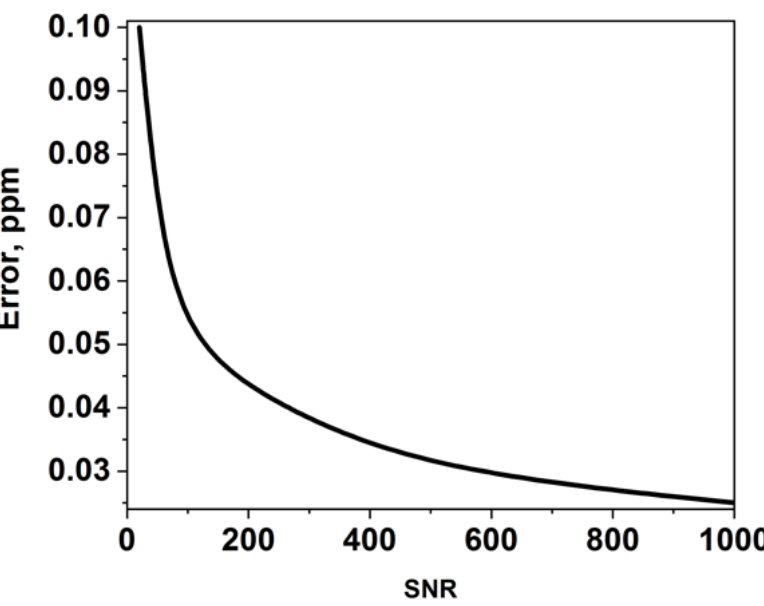
Figure 16. Estimation of CH 4 mean mixing ratio above 40 km based on solar occultation synthetic spectra measured at the tangent altitude of 5 km with the different signal-to-noise ratio.